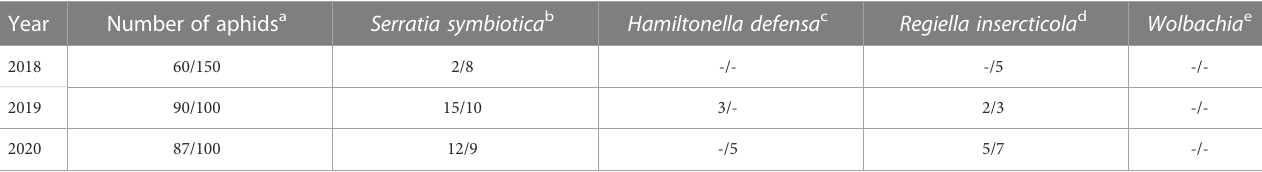
TABLE 1 Detection of bacterial symbionts in Sitobion miscanthi and Rhopalosiphum padi with speci fi c